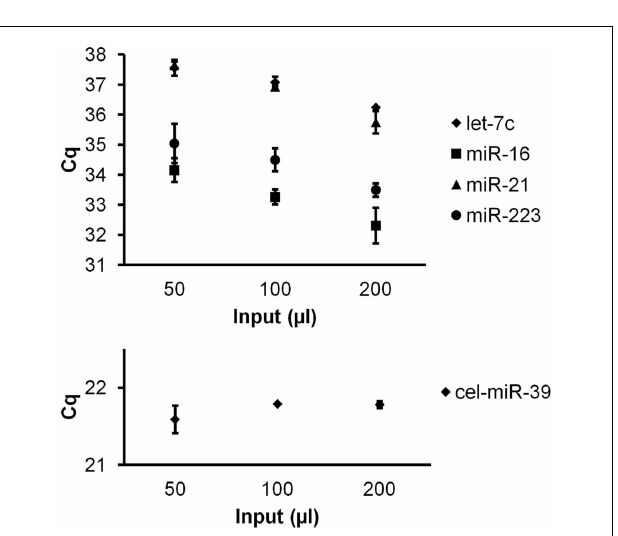
FIGURE 5 | Quantitative recovery of RNA from cerebrospinal fluid by Exiqon Biofluids .The Exiqon Biofluids kit was used to isolate RNA in duplicate isolations for each of three quantities of CSF. Linear response to input volume is shown for four endogenous miRNAs as indicated (measured in triplicate for each isolation), as well as spiked-in cel-miR-39 (same input amount for each isolation). Bars represent range of Cq values for the duplicate